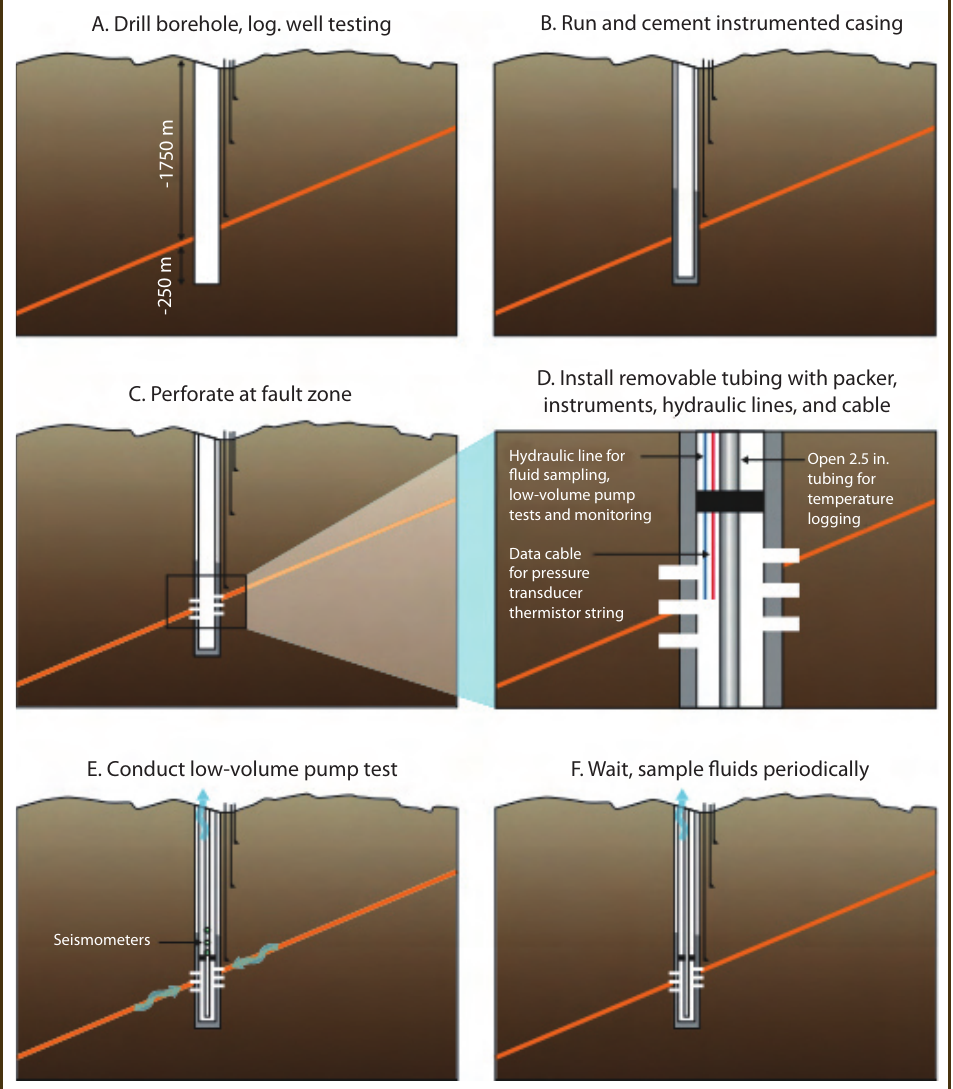
instrument Figure 4 . Schematic of a rapid drilling